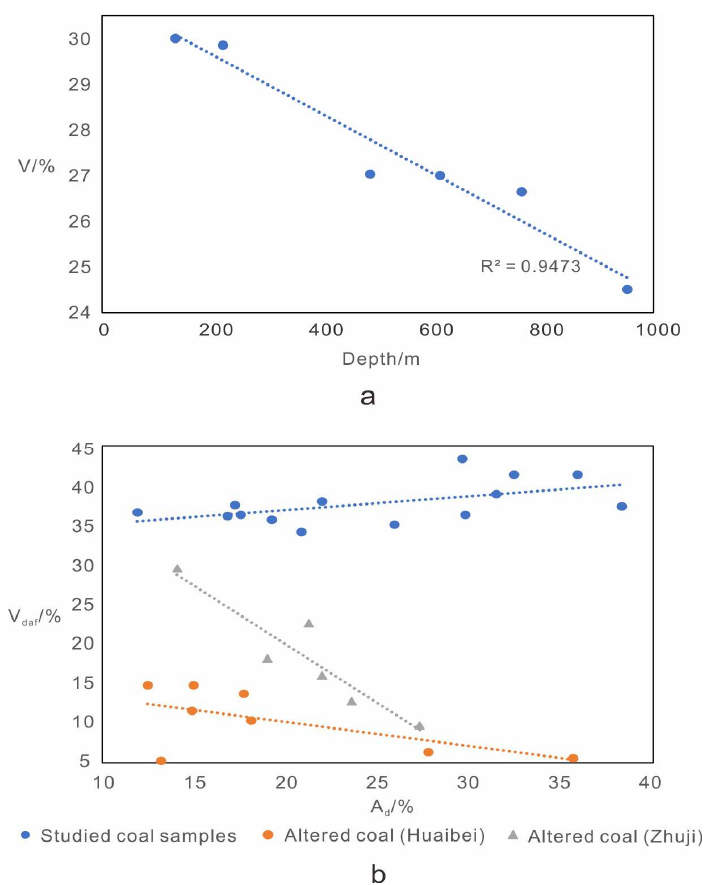
Figure 9. Volatile matter content variation in Huainan coalfield. ( a ) The correlation between volatile matter and depth of coal seams in the WFG mine [37] and ( b ) the correlation between volatile matter and ash yield (data on altered coal of Huaibei coalfield are quoted from Yao et al. [13]; data on altered coal of the Zhuji mine of the Huainan coalfield from Wu [18]).